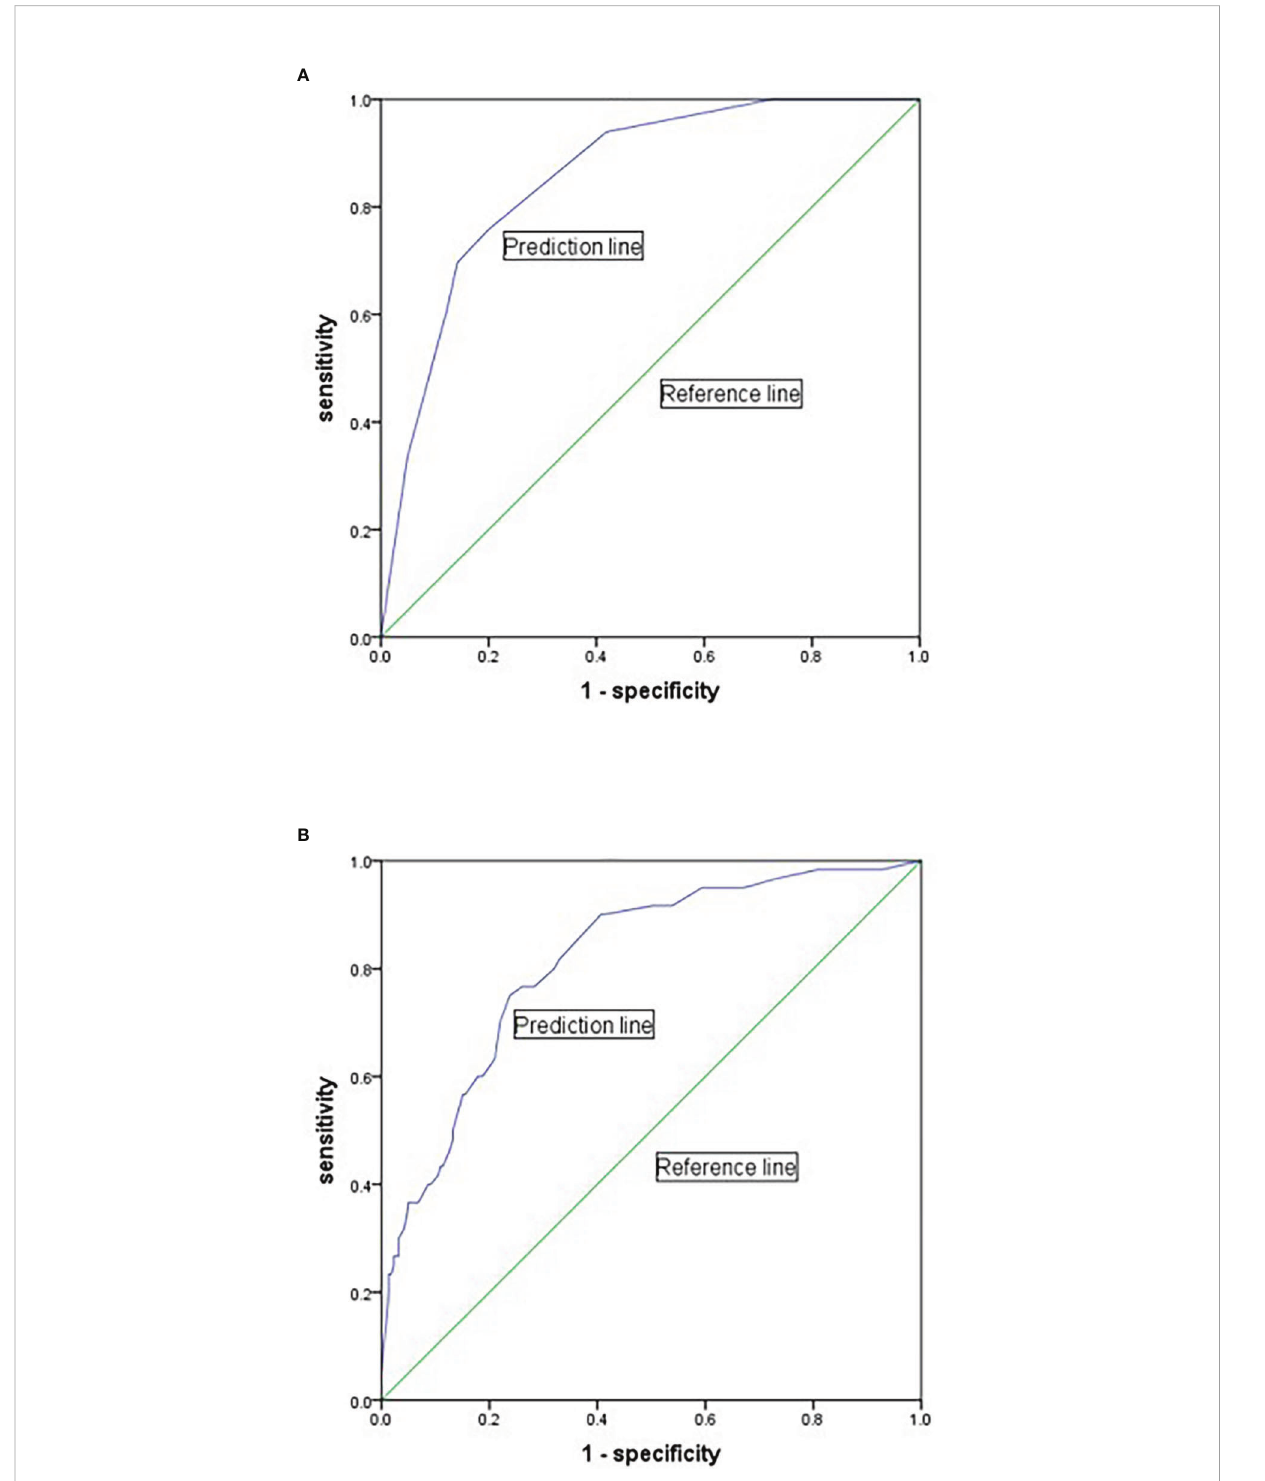
FIGURE 4 Receiver-operator characteristic curve for predicting the 28-day mortality and septic shock of BSI-KP. (A) The model was based on the variables of statins use, quinolones use and vasoactive agent use to predict 28-day mortality. (B) The model was based on the variables of gender, pulmonary disease, bleeding and coagulation disorders, respiratory failure, kidney dysfunction and hypertension for predicting septic